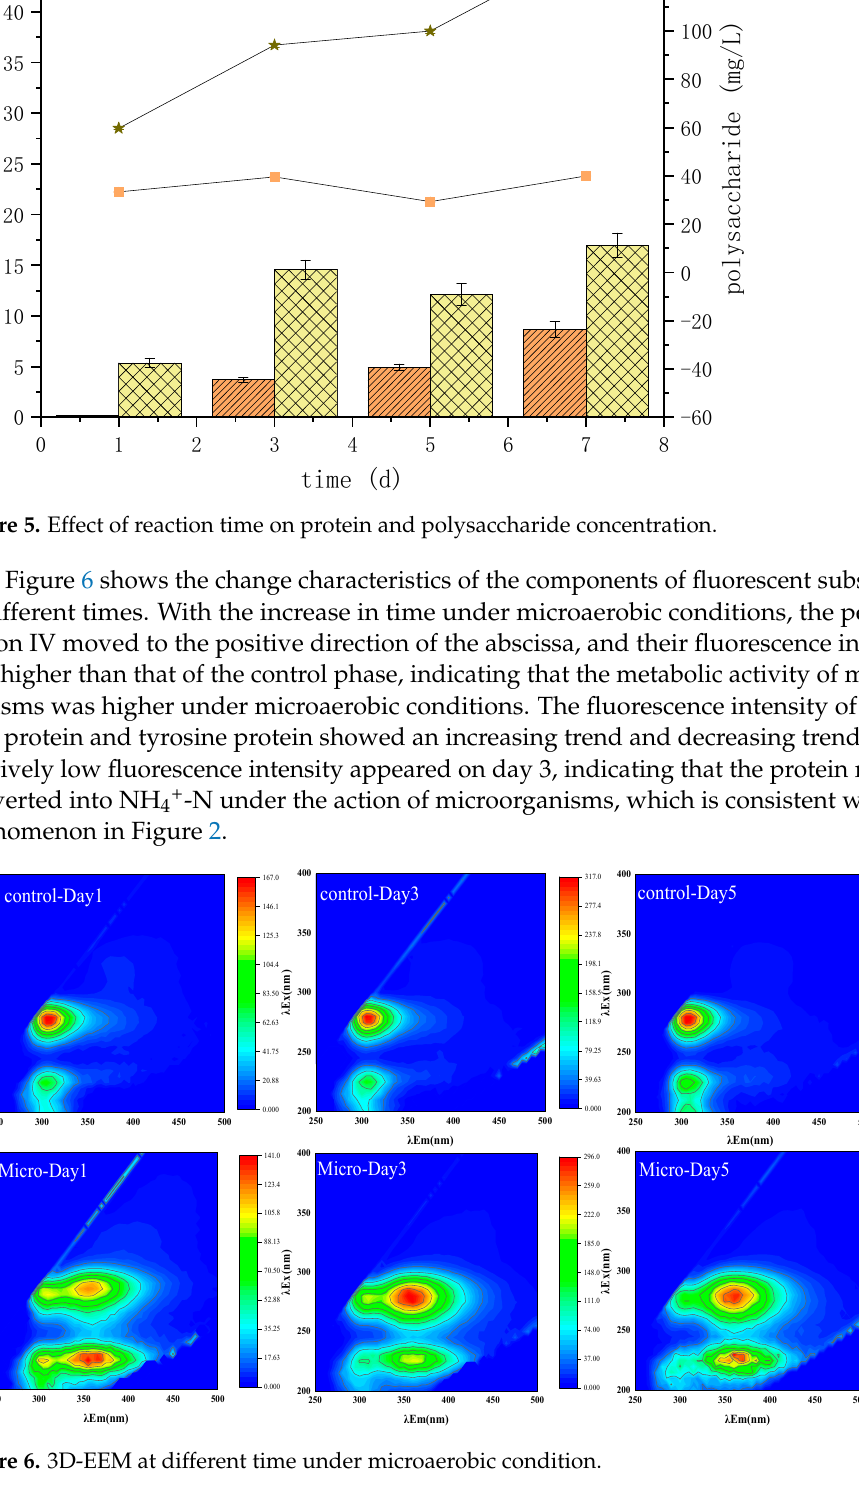
Figure 6. 3D-EEM at different time under microaerobic condition.